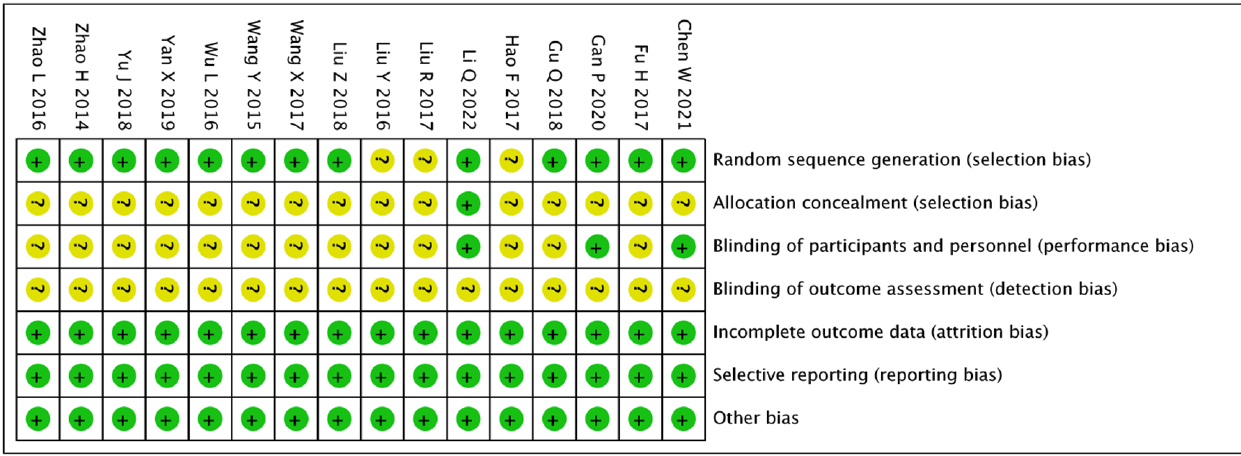
Figure 3. Risk of bias proportional to the risk of inclusion in the literature.